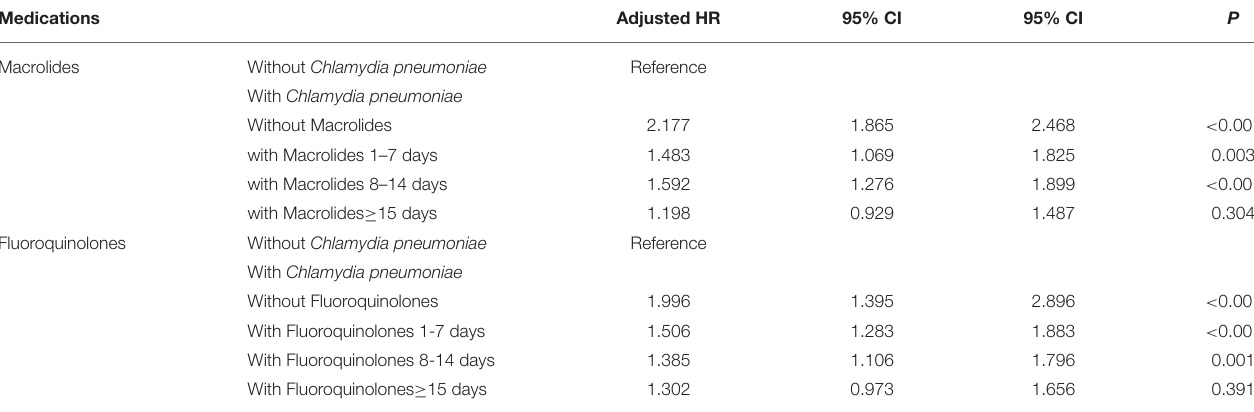
TABLE 3 | Factors for Alzheimer dementia among different usages of antibiotics by using Fine and Gray’s competing risk model. Medications